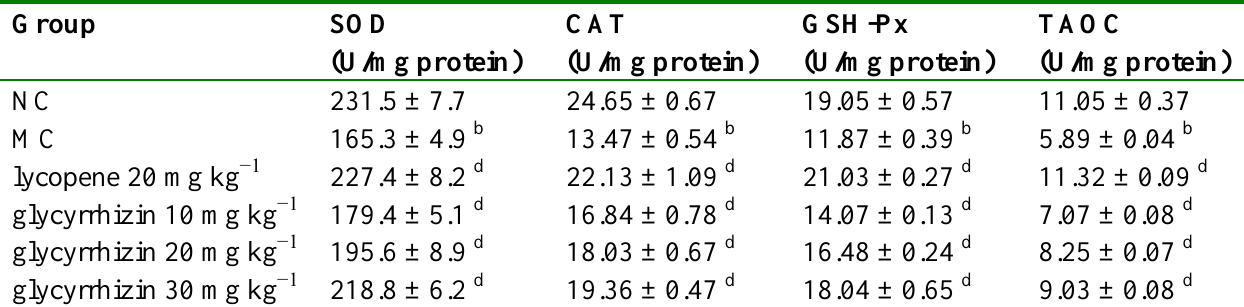
Table 6. Nasal mucosa SOD, CAT, GSH-Px and TAOC activities in different groups.